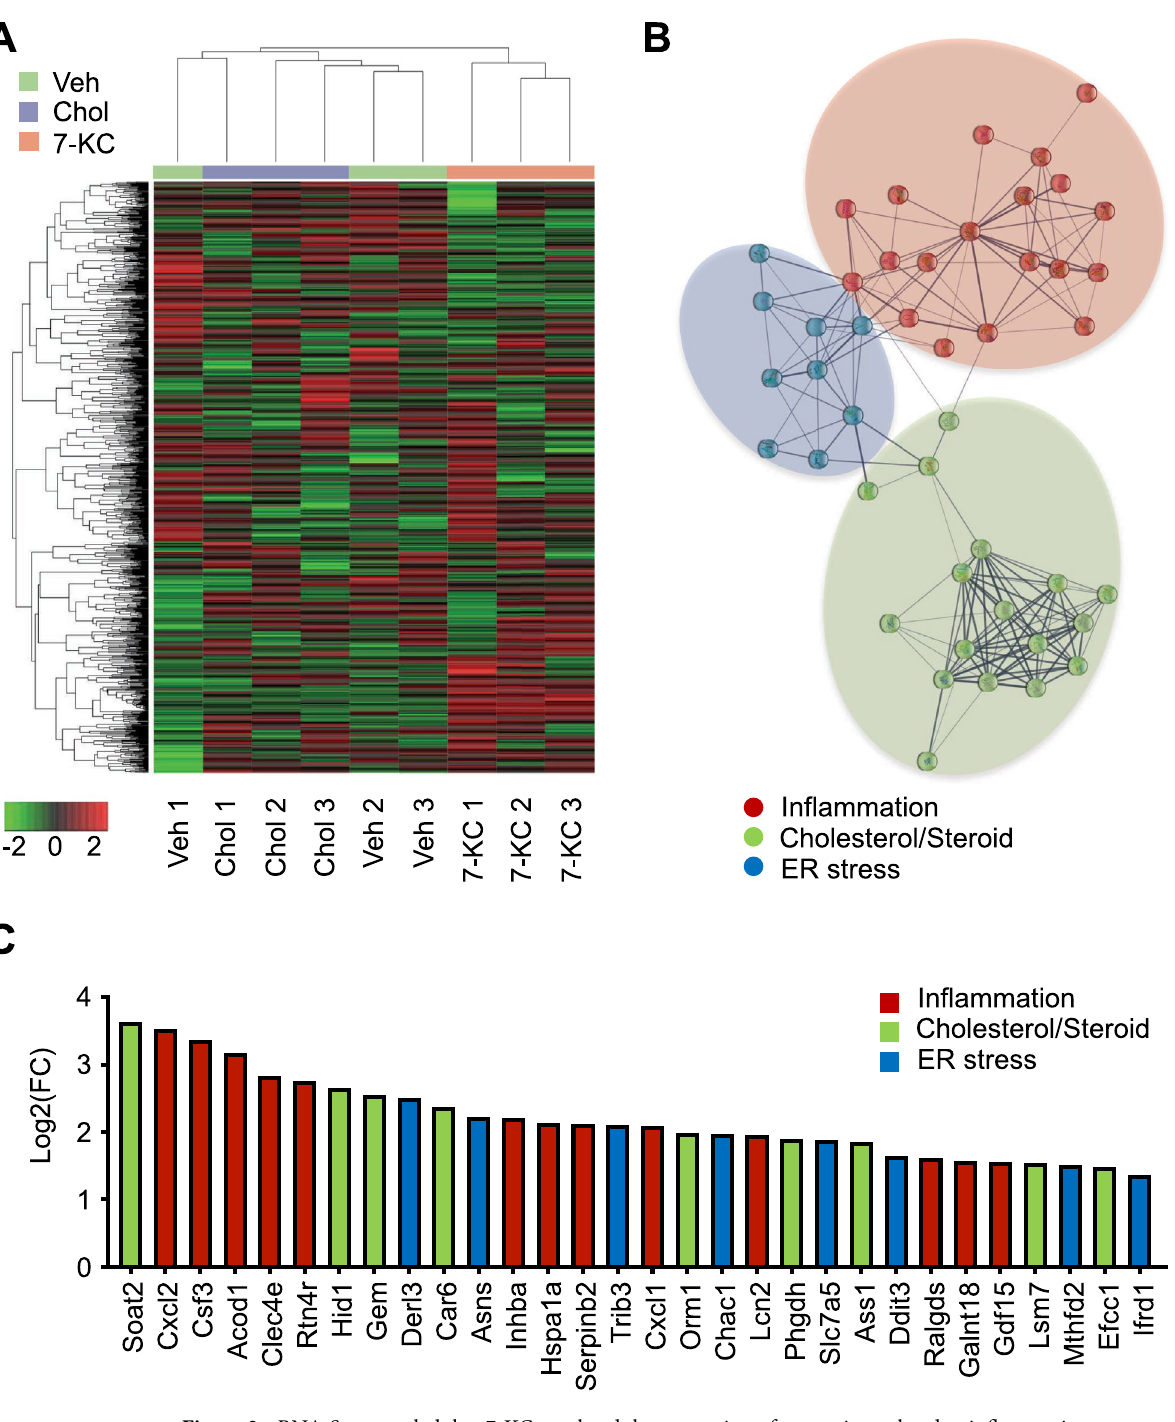
Figure 3. RNA-Seq revealed that 7-KC regulated the expression of transcripts related to inflammation, cholesterol biosynthesis and ER stress. RNA-Seq was performed using RNAs extracted from peritoneal macrophages treated with vehicle, 10 µM cholesterol or 7-KC for 24 h. N = 3. ( A ) Transcriptomic heatmap for the 3 groups. The heatmap was visualized using iDEP software (version 0.94) (http:// bioin forma tics. sdsta te. edu/ idep/). ( B ) and ( C ) Network analysis ( B ) and top 30 differentially overexpressed mRNAs ( C ) in macrophages treated with 7-KC compared to those treated with cholesterol. Transcripts were categorized as inflammation- (red), cholesterol/steroid metabolism- (green), and ER stress-associated genes (blue). The network analysis was visualized using STRING software (version 11.5) (https:// string- db. org). RNA-Seq, RNA sequencing; Veh, vehicle; Chol, cholesterol; 7-KC, 7-ketocholesterol; ER, endoplasmic reticulum; FC, fold